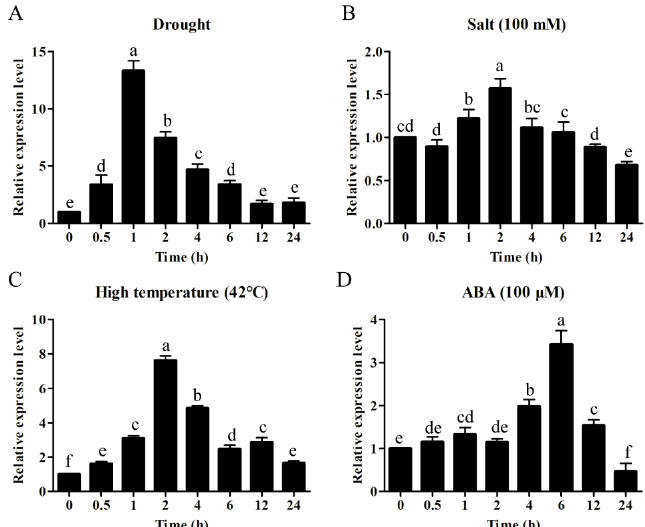
Figure 4. Expression patterns of ZmWRKY106 under ( A ) drought, ( B ) high-salt, ( C ) high-temperature, and ( D ) exogenous abscisic acid (ABA) stresses. The ordinates are the relative expression level (fold) of ZmWRKY106 compared to the non-stressed control. The horizontal ordinate is treatment time for 0, 0.5, 1, 2, 4, 6, 12 and 24 h. All experiments were repeated three times. Error bars represent standard deviations (SDs). All the data represent the means ± SDs of three independent biological replicates. The different letters in the bar graphs indicate significant differences at p <